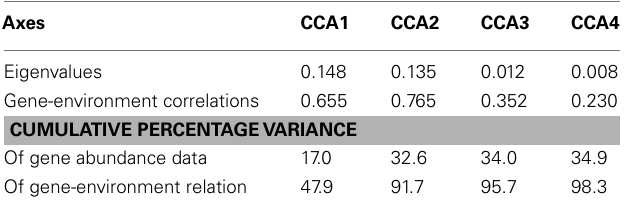
TableA6 | Results of CCA analysis of relationship between qPCR-estimated gene abundances and environmental data in the northern Gulf of